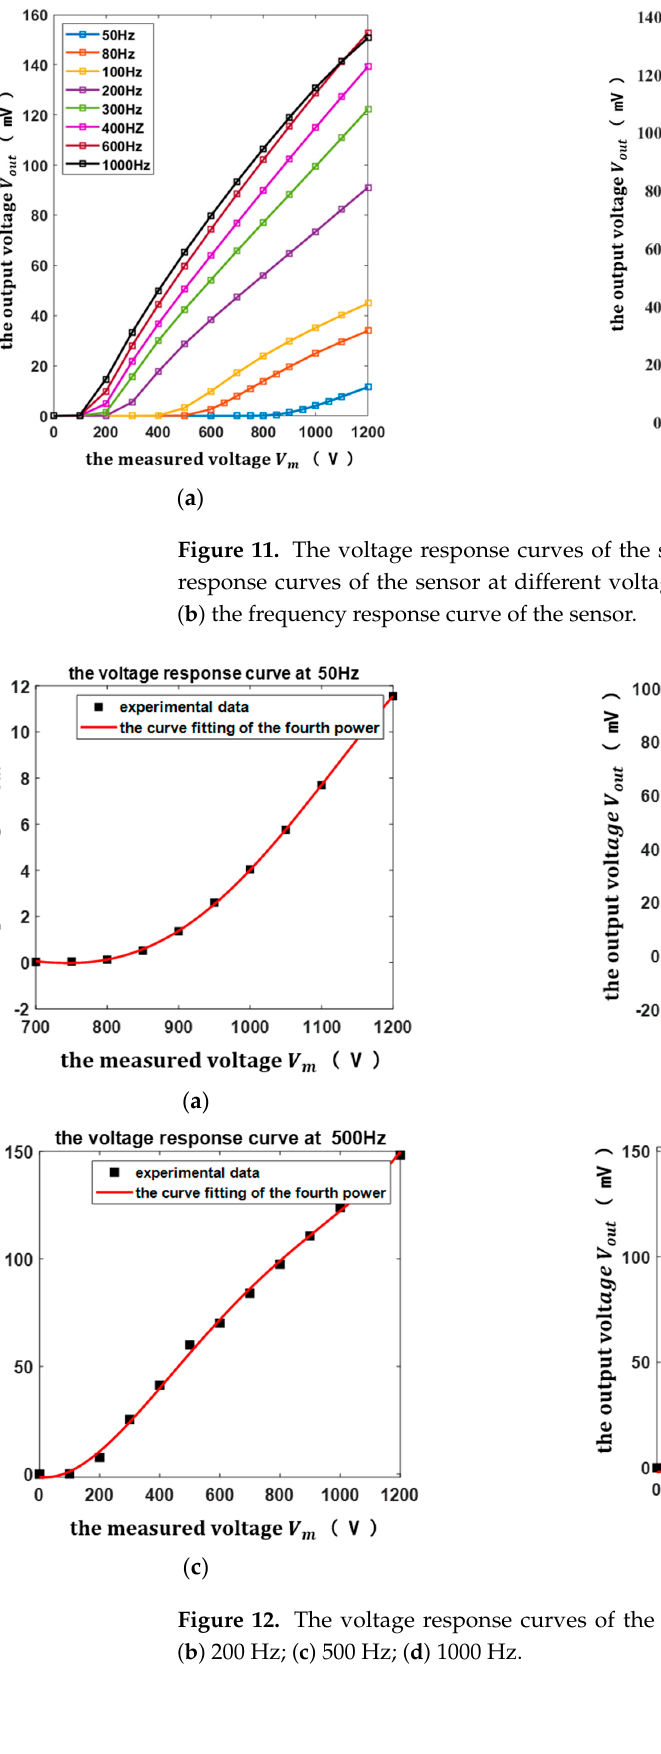
9 of 13 Figure 10. Photo of the experimental setup.